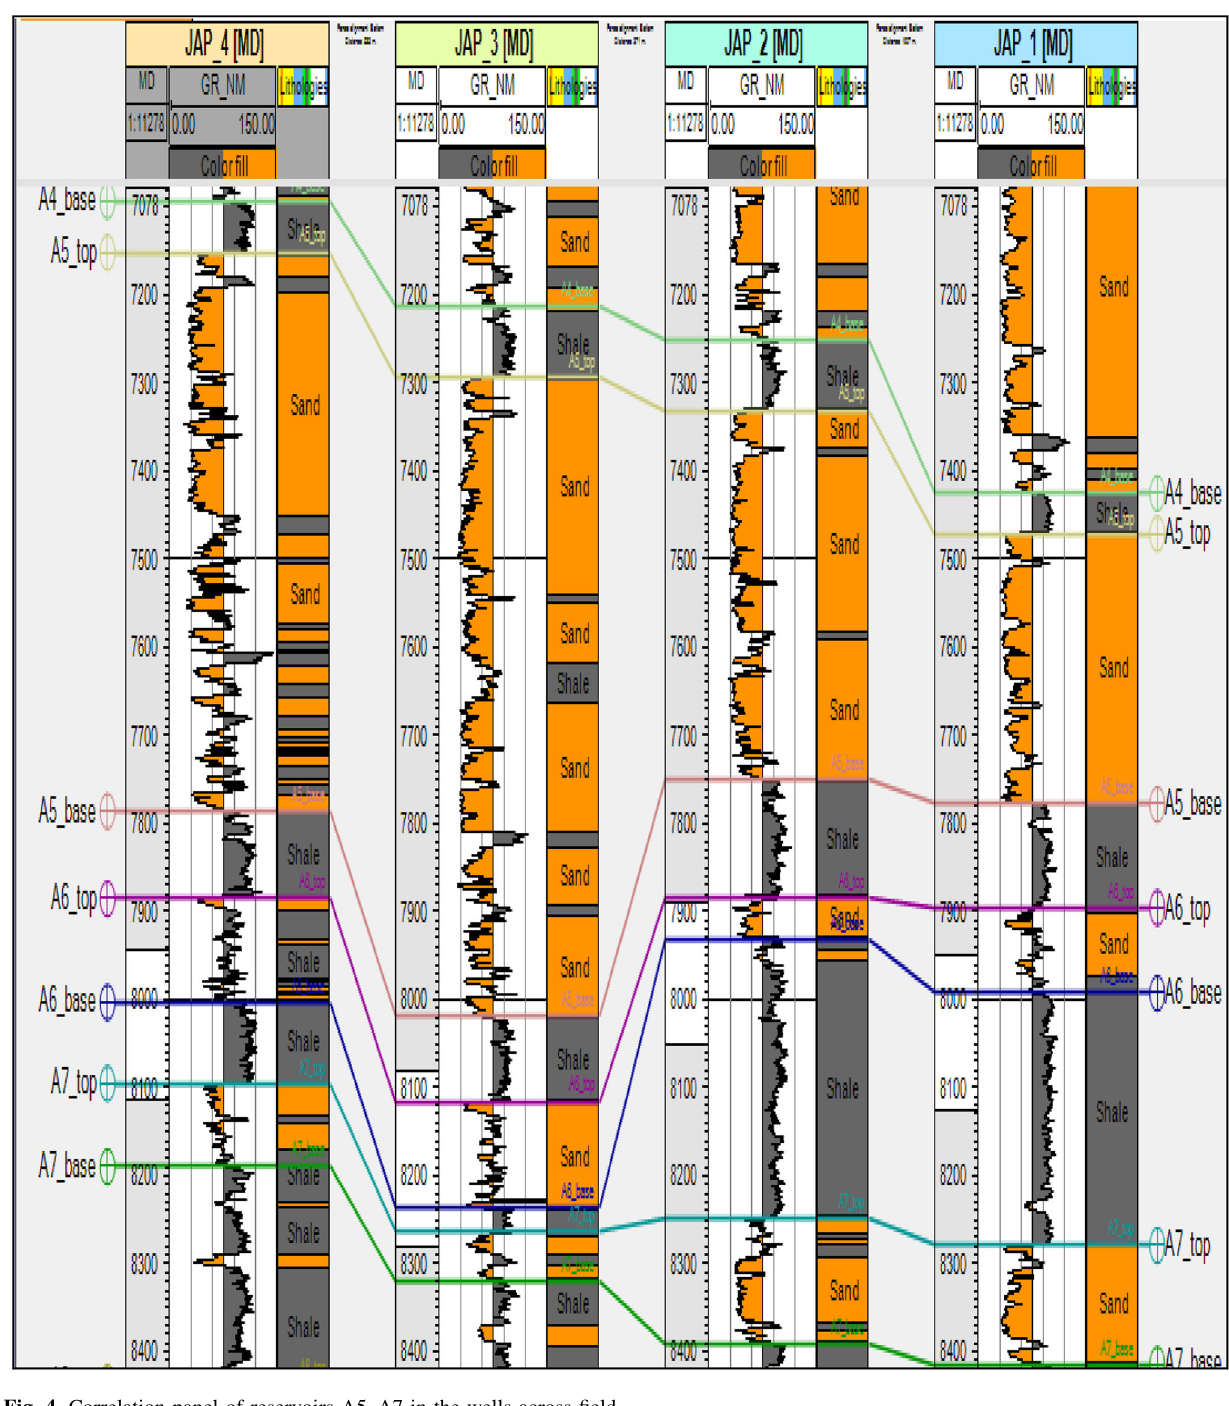
Fig. 4 Correlation panel of reservoirs A5–A7 in the wells across